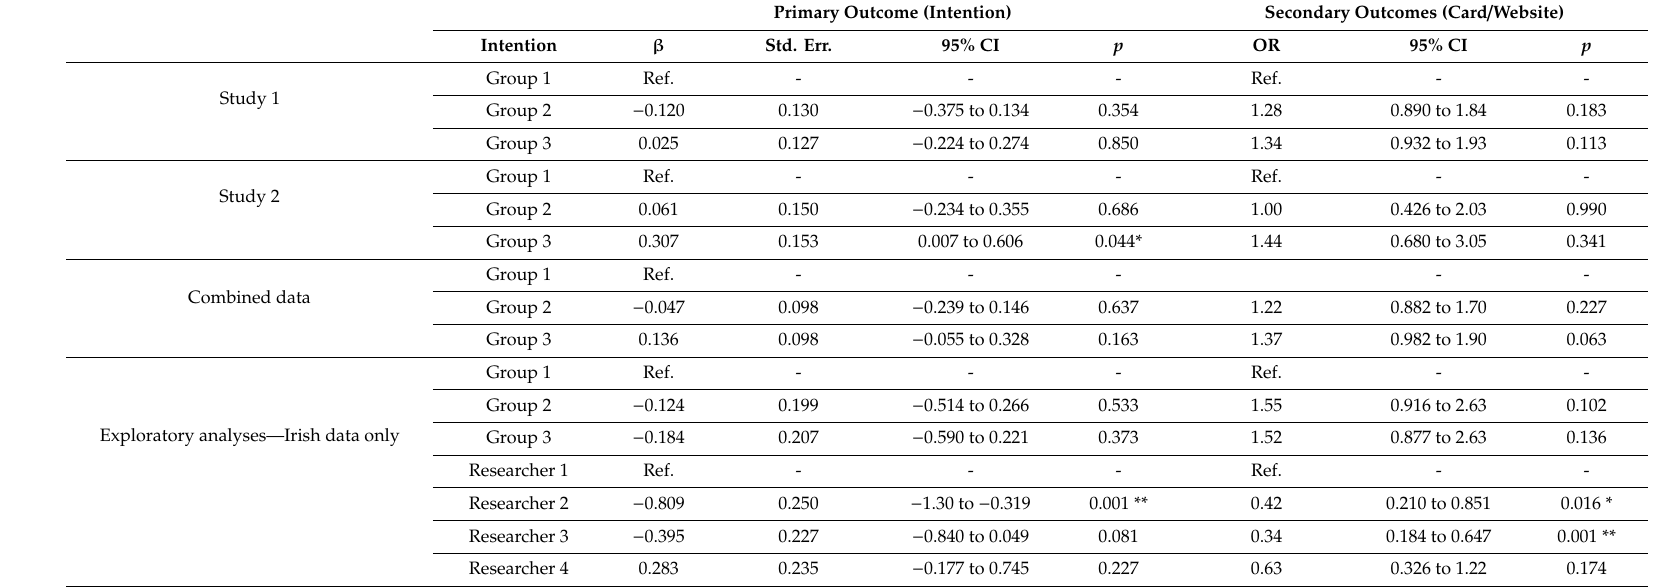
Table 3. Results of regression models predicting